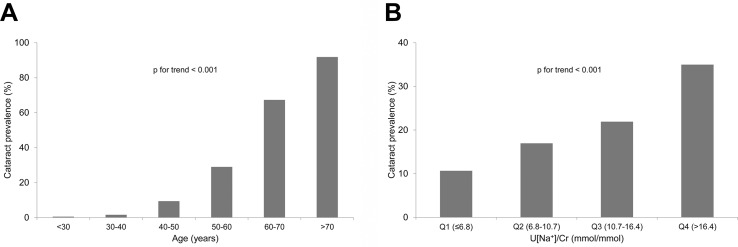
The prevalence of cataracts across age groups (A) and quartiles of urinary sodium to creatinine ratios (U[Na+]/Cr) (B).